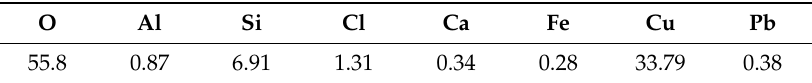
Figure 5. SEM image of region with fixed Cu, magnitude 7000×. Table 4. EDS analysis of the Cu cluster (atom %)